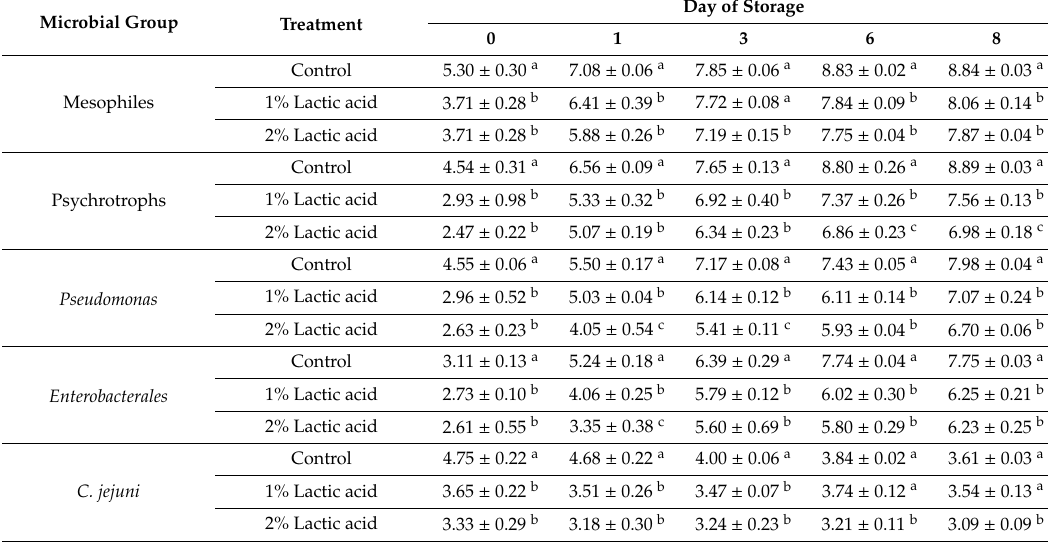
Table 1. E ff ect of lactic acid on the mesophilic, psychrotrophic, Pseudomonas, Enterobacterales , and Campylobacter jejuni counts on chicken legs (log cfu /